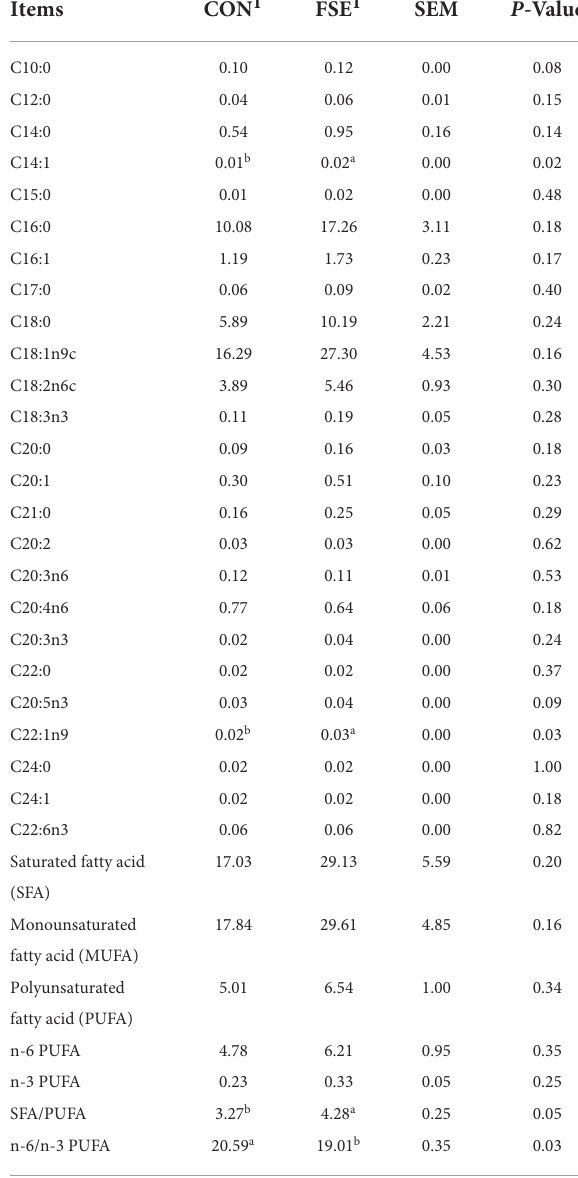
TABLE 4 Effect of Forsythia suspensa extract on the fatty acid composition in the longissimus dorsi muscle of finishing pigs (mg/g tissue of muscle, dry matter